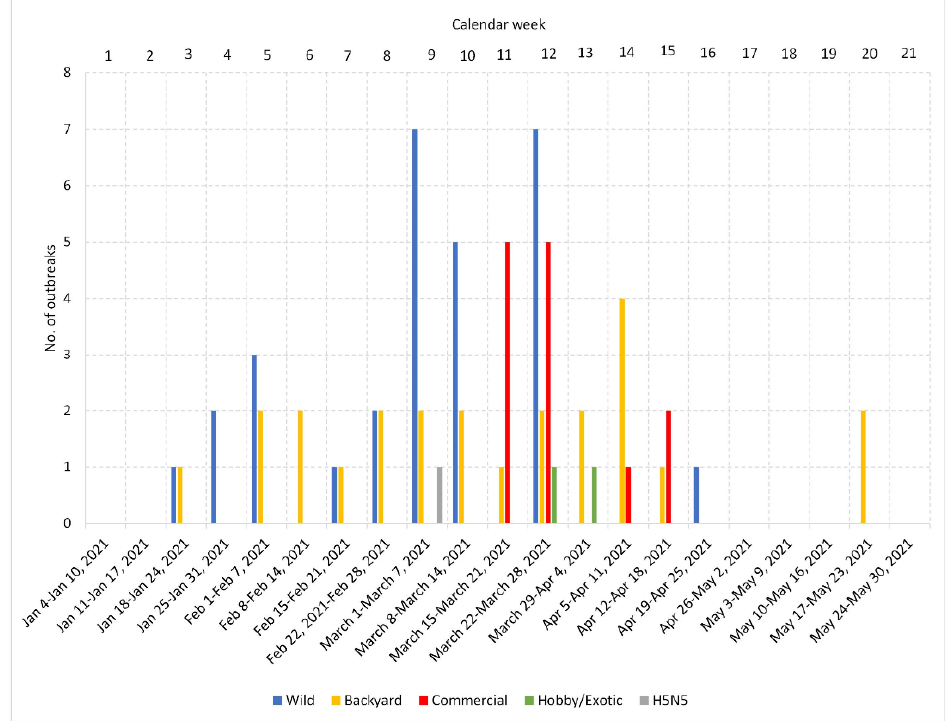
Figure 1. Distribution of HPAI outbreaks in calendar weeks and geographical locations. Bar chart showing the cumulative number of HPAI outbreaks in each calendar week in the Czech Republic. Geographical distribution of the outbreak localities is provided in the map available online at https://www.google.com/maps/d/u/0/viewer?mid=1MNHHITwI- vLUs0sk36Z75OjPGt9h98OqZ&fbclid=IwAR2nXOIkdSAZDUeddMQXcYQH5Y33Yyb2cd5cQ46E